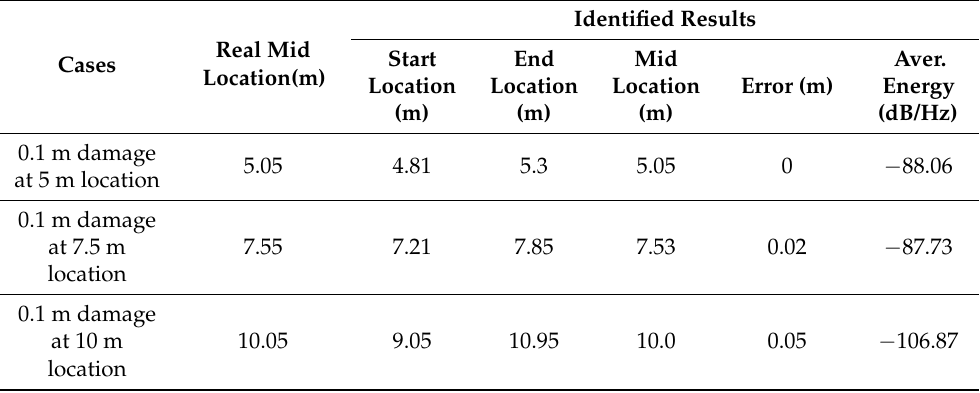
Table 7. Comparison of the predicted and real damage locations.